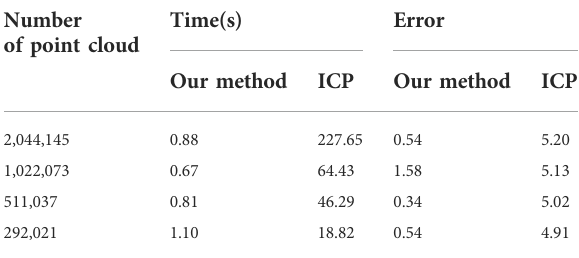
TABLE 3 Comparison of registration time and error of different scales. Number of point